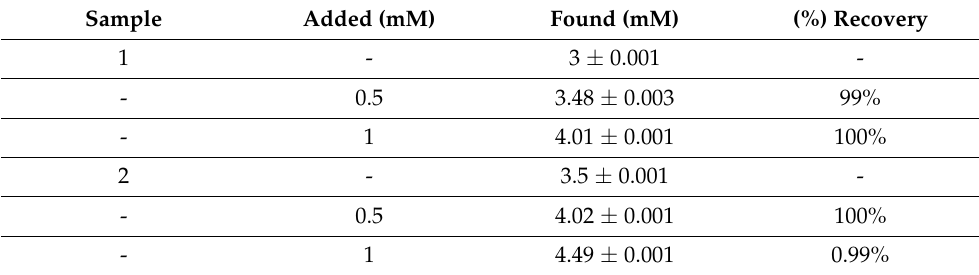
Table 4. Urine sample analysis using % recovery method for the detection of urea.